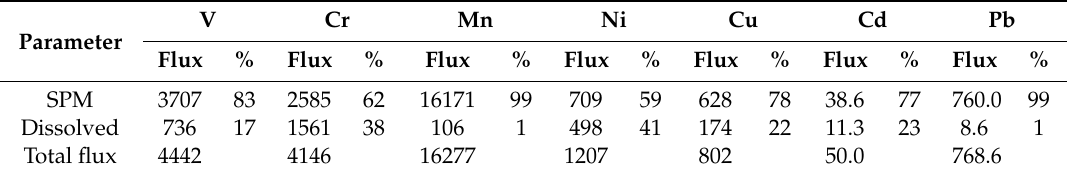
Table 7. Export fluxes of heavy metals (t yr − 1 ) and proportions (%) of SPM and the dissolved flux to the total flux in the Zhujiang River.